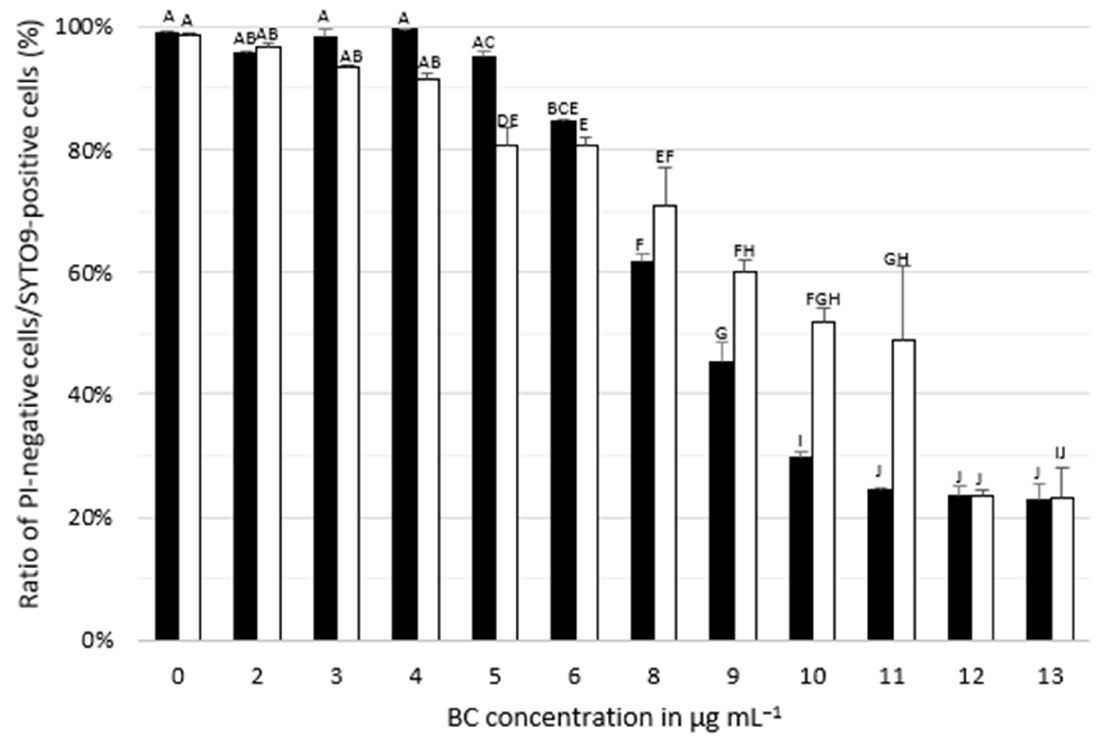
Figure 2. Mean ratio of PI-negative to SYTO9-positive parent (black bars) and adapted (white bars) Listeria monocytogenes SLCC2540 cells following cultivation in BHI containing benzalkonium chloride (BC) in various concentrations. SYTO9-positive cells are indicative of total cell counts, while PI-negative cells are a surrogate for intact cell membranes. Error bars indicate the standard deviation of three replicates. Different letters above bars within panels represent significant differences ( p < 0.05) according to two-way analysis of variance (ANOVA).